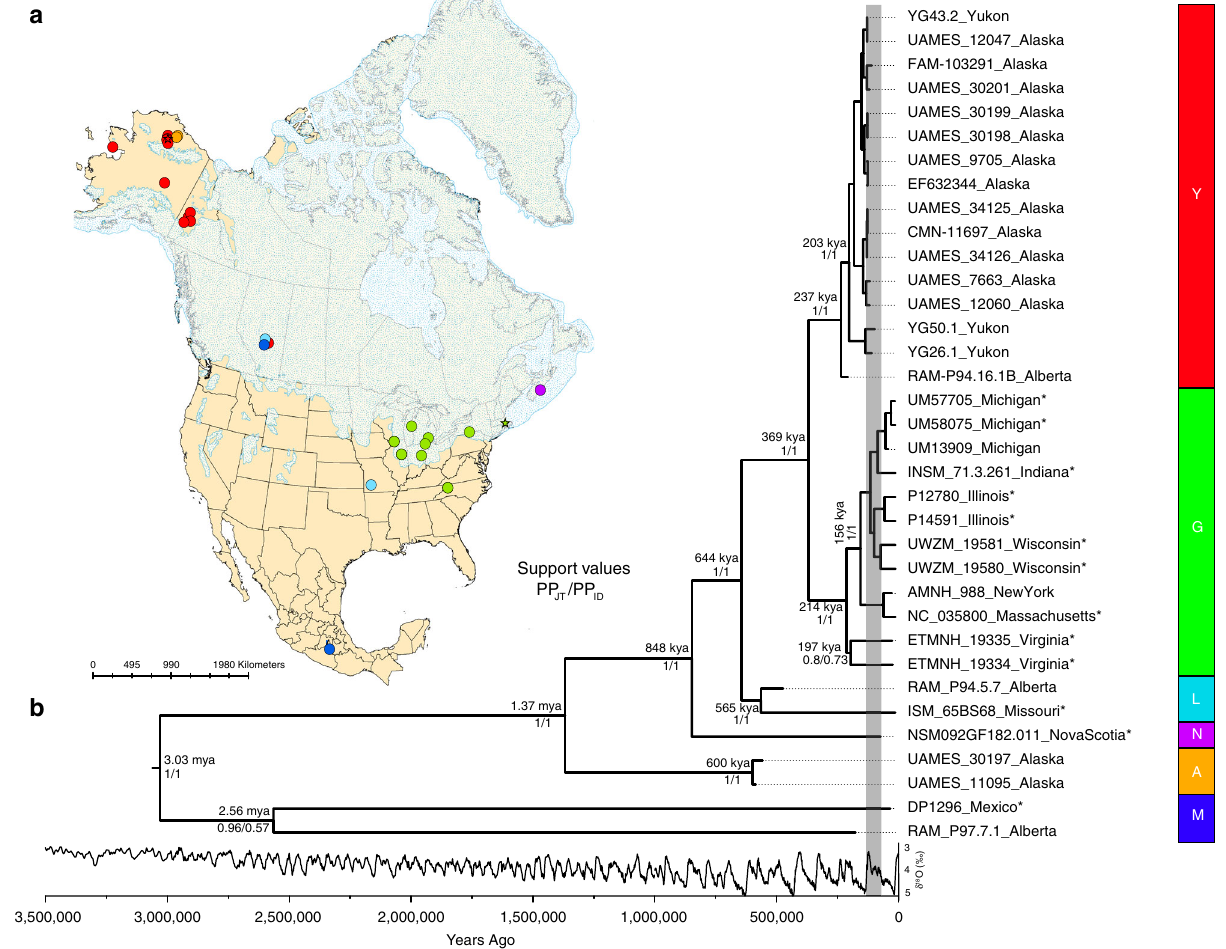
Fig. 1 Phylogeographic relationships of American mastodons. a Locations of specimens included in this study. Circles indicate specimens for which complete mitochondrial genomes were obtained, coloured according to their clade assignment. Stars indicate previously sequenced specimens (EF632344, Alaska; NC_035800, Massachusetts). The locations of specimens from Alberta and eastern Beringia have been jittered to aid visualisation (see Supplementary Fig. 2 for an unmodi fi ed version). b Phylogenetic tree inferred by the Joint analysis. Median posterior ages are given for major nodes in the tree. Support values for each node represent posterior probabilities from the Joint (PP JT ) and Individually Dated (PP ID ) analyses. The δ 18 O record for the last 3.5 million years is shown below the tree 7 , with the approximate extent of the MIS 5 interglacial period shaded in grey. Clades identi fi ed in this study are designated by colour and named where possible by the geographic provenance of their members (i.e., A Alaska, Y Yukon, G Great Lakes, M Mexico, N Nova Scotia, L Alberta/Missouri). Specimens with fi nite radiometric or geological ages are indicated with